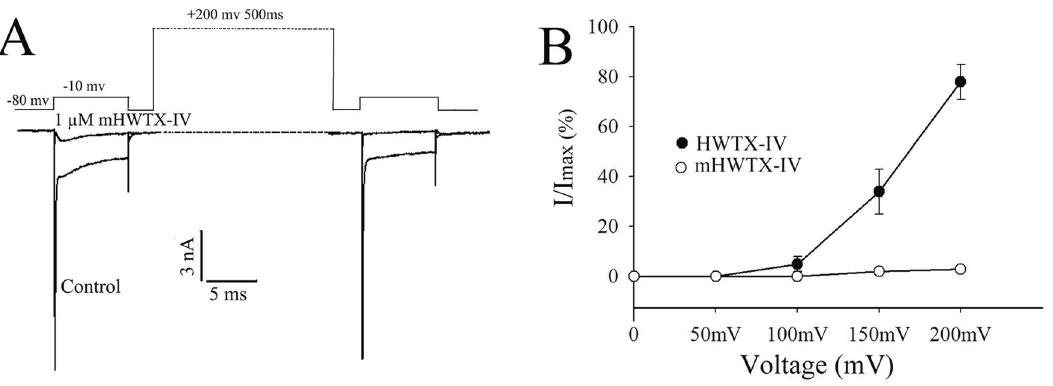
Figure 7. Sodium current recording after the application of mHWTX-IV detected by strong depolarization. (A) DRG neurons were held at 2 80 mV and then with a 50 ms test pulse of 2 10 mV. A + 200 mV 500 ms strong depolarization applied after cell back held at 2 80 mV. Finally, a 2 10 mV pulse used to test the currents. After the + 200 mV strong depolarization, no current was induced. (B) Recovery of current from Nav1.7 following strong depolarization in the presence of 1 m M HWTX-IV or 1 m M mHWTX-IV. HEK293 cells were depolarized to + 200, + 150, + 100 and + 50 mV. Control for each panel means no toxin treatment. Every data point (mean 6 S.E.) was obtained from five separate experimental cells.